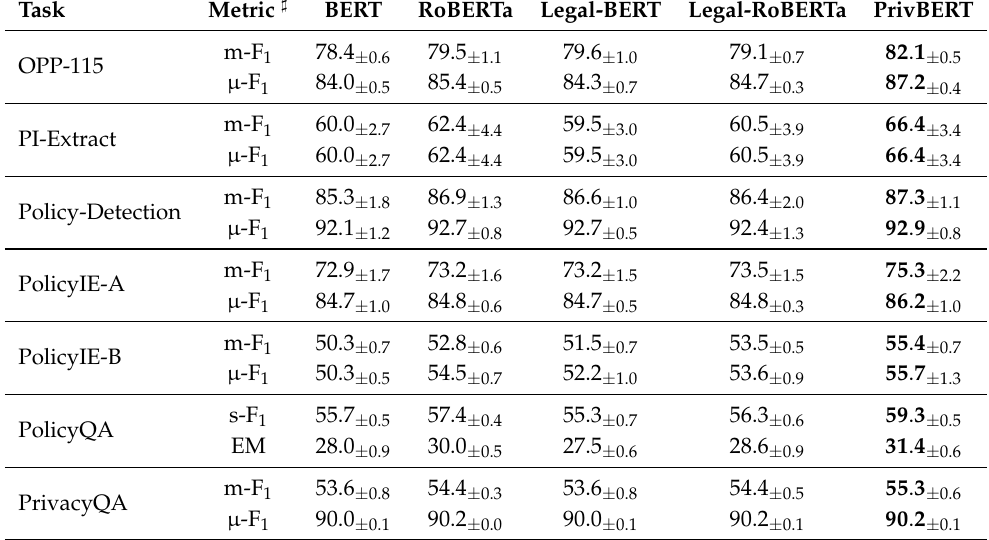
Table A3. Test-set results of the PrivacyGLUE benchmark; (cid:93) m-F 1 refers to macro-average F 1 , µ -F 1 refers to the micro-average F 1 , s refers to sample-average F 1 , EM refers to the exact match accuracy, metrics are reported as percentages with the following format: mean ± standard deviation